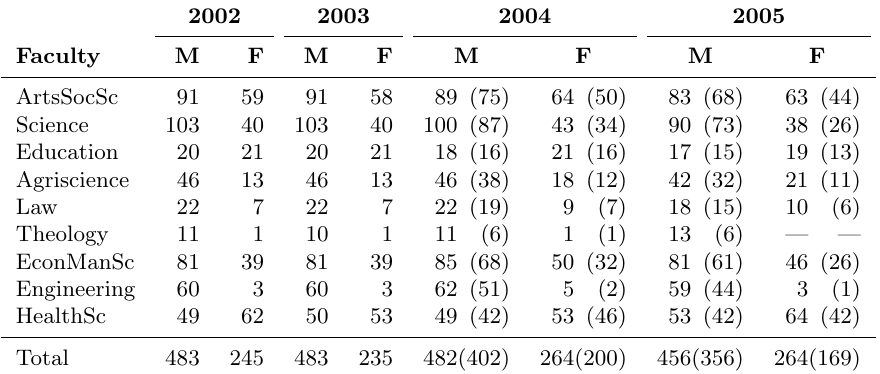
Table 1: The number of full-time C1 staff members in the different Faculties according to Gender for 2002, 2003, 2004 and 2005. Individuals comprising the 2003 data set are almost identical to the individuals in the 2002 baseline data set. The numbers in brackets for the 2004 and 2005 data sets show the number of individuals who were also in the baseline data set of